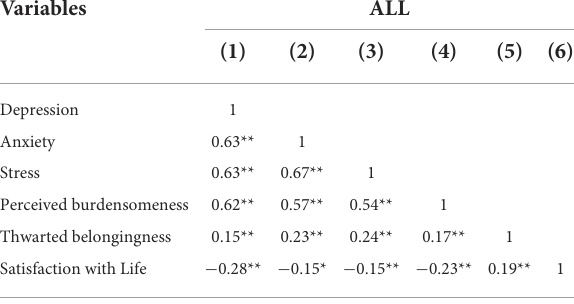
TABLE 4 Correlation between variables.